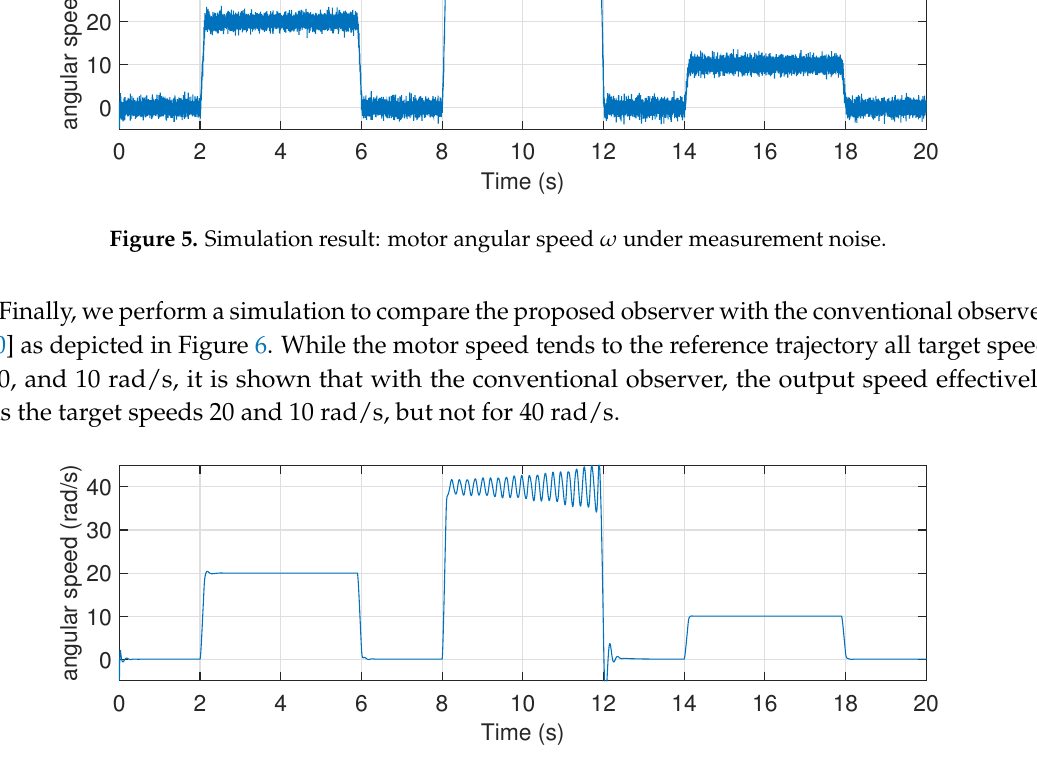
Figure 6. Simulation result: motor angular speed ω under the conventional observer in